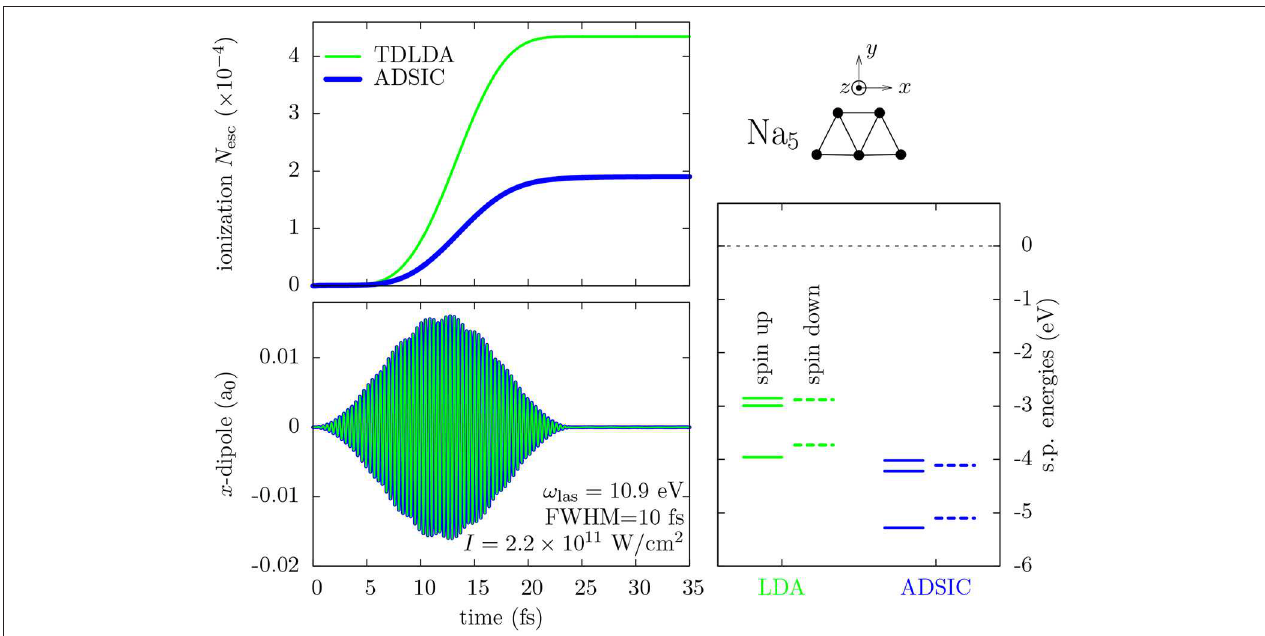
FIGURE 1 | Comparison of (TD)LDA and ADSIC for the Na 5 cluster. (Top right) Sketch of ionic configuration of Na 5 . (Bottom right) Single particle (s.p.) energies for spins up (full lines) and down (dashes). (Left) Time evolution of total ionization N esc (top) and of the electronic dipole in the x direction (bottom) after irradiation by a laser pulse polarized along x with ω las = 10.9 eV, T pulse = 24 fs, and I = 2.2 × 10 11 W/cm 2